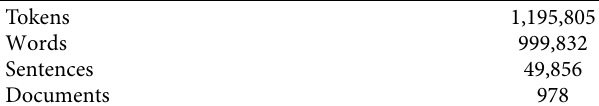
Figure 1: Process of corpus development. Table 1: General statistics of the corpus.